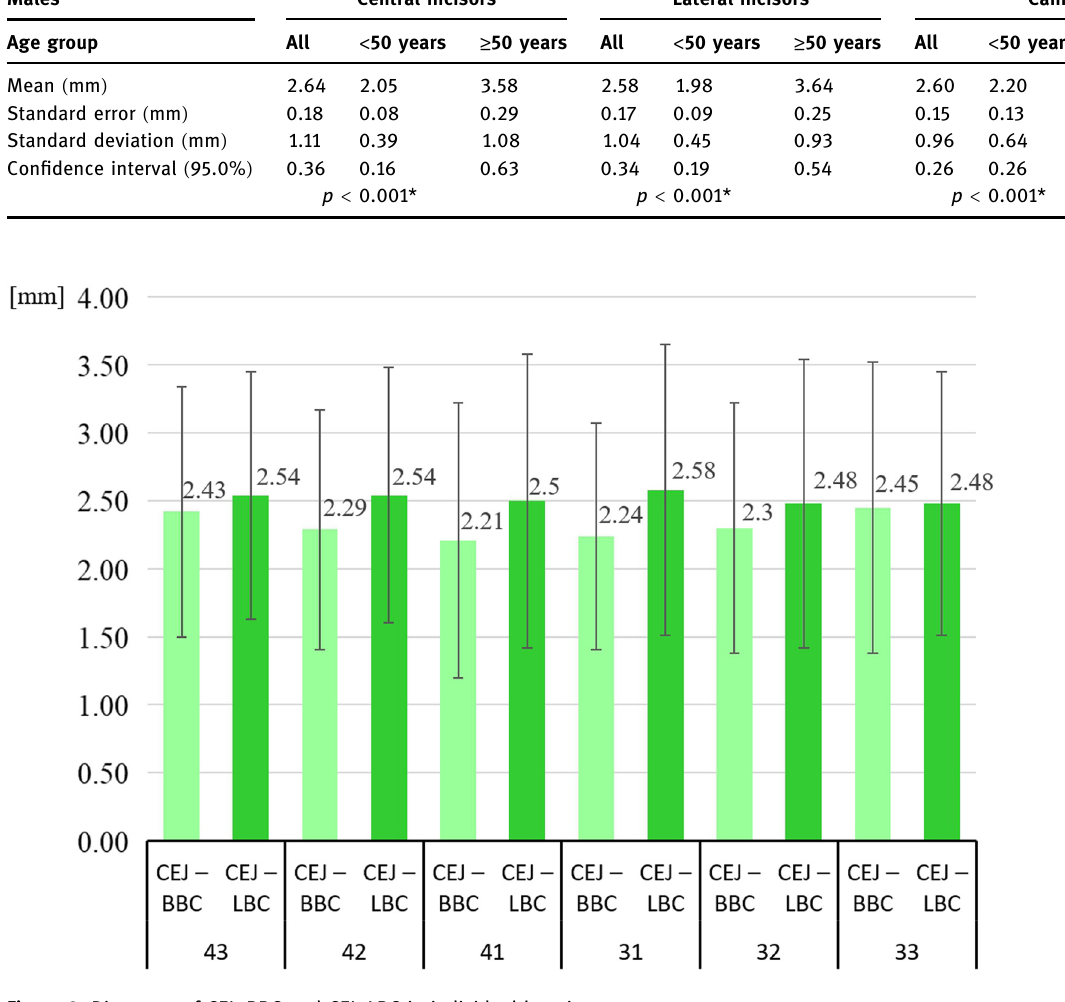
Figure 3: Distances of CEJ – BBC and CEJ – LBC in individual